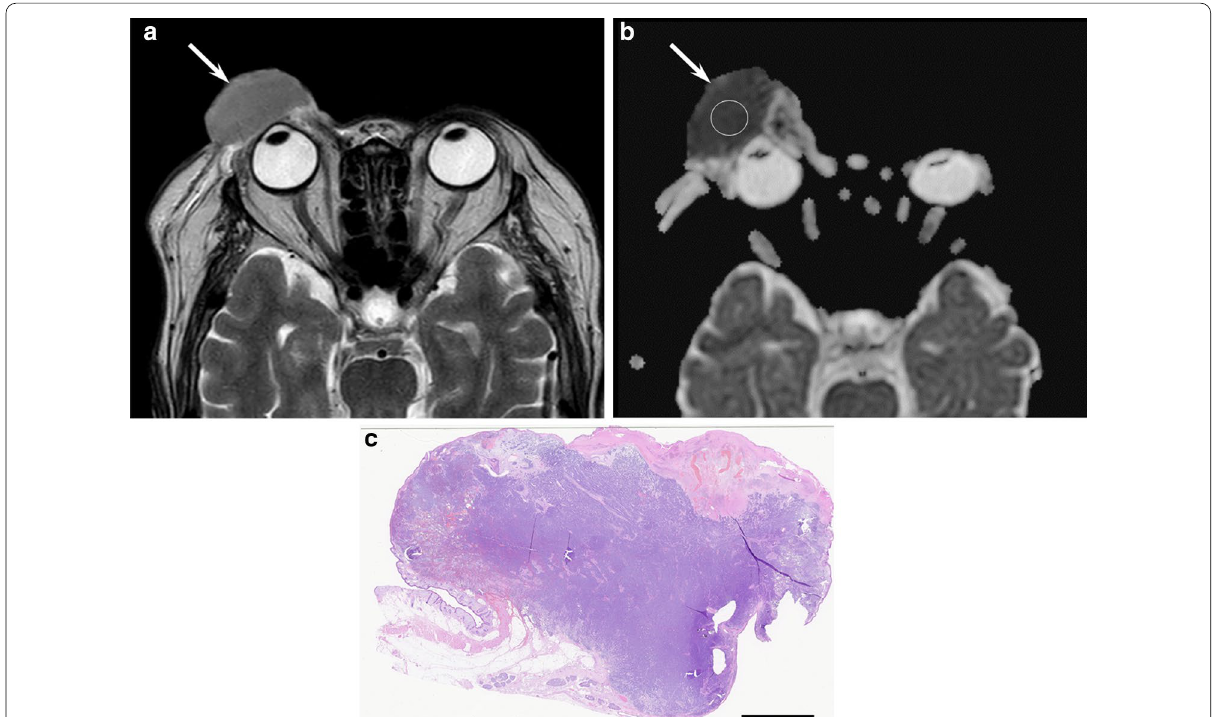
Fig. 10 A 79‑year‑old female with Merkel cell carcinoma on the eyelid. a Axial T2‑weighted image showing an elevated cutaneous mass with homogeneously mild hyperintensity (arrow). b Axial apparent diffusion map image showing marked restricted diffusion (0.5 c Histological specimen (H&E stain; scale bar, 5 mm) showing a hypercellular mass in the dermis and subcutaneous